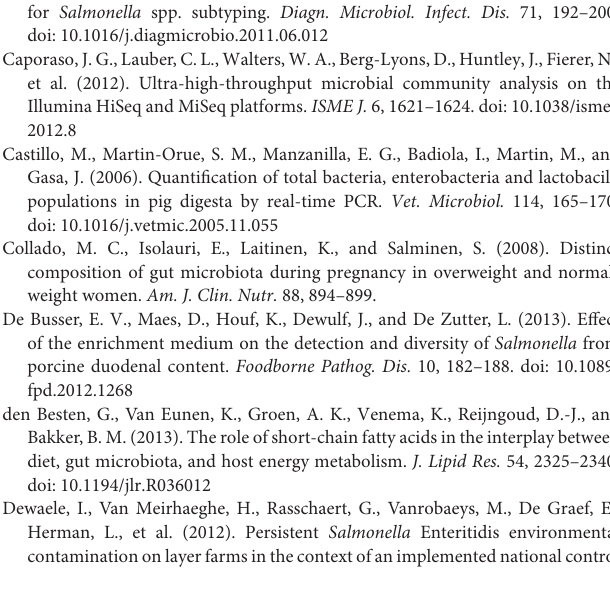
FIGURE S1 | Rarefaction curve comparing the number reads with the average number of OTUs found in all sequenced samples of sows’ feces for 1000